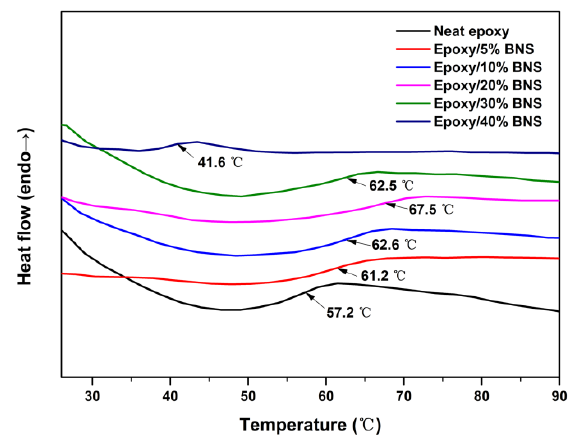
Figure 7. DSC (di ff erential scanning calorimetry) curves of epoxy / BNS composites with a heating rate Figure 7. DSC (differential scanning calorimetry) curves of epoxy/BNS composites with a heating of 5 ◦ C min − 1 under rate of 5 °C min −1 under Ar.